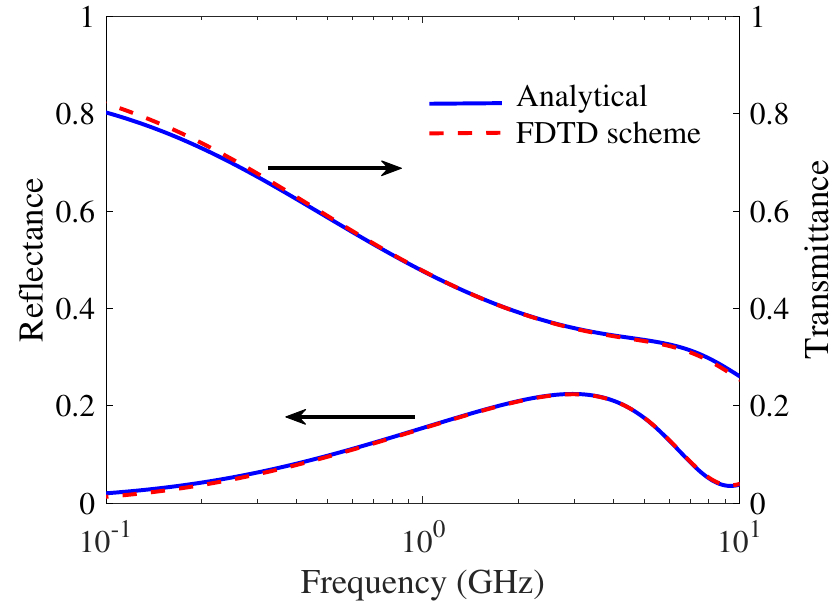
with relaxation time τ = 318 ps. The exponents and coefficients characterizing the poly- nomials involved in (73) were arbitrarily chosen. Starting from the space-time field dis- tribution, the reflectance and transmittance spectra were evaluated and compared with that calculated using the analytical technique based on the transfer matrix approach (see Figure 2) [107].